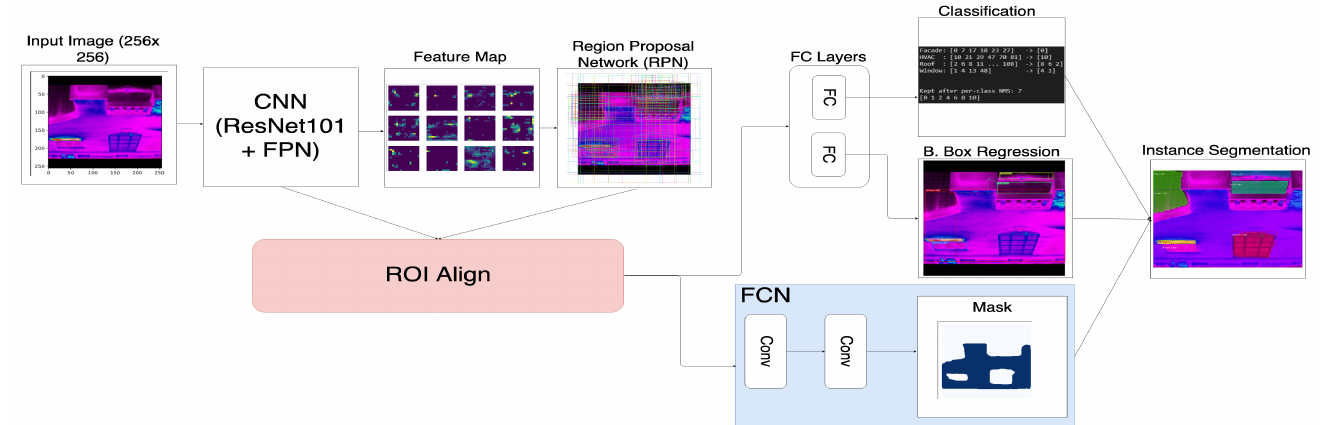
Figure 1. Illustration of the Mask R-CNN architecture with an input image at each stage of